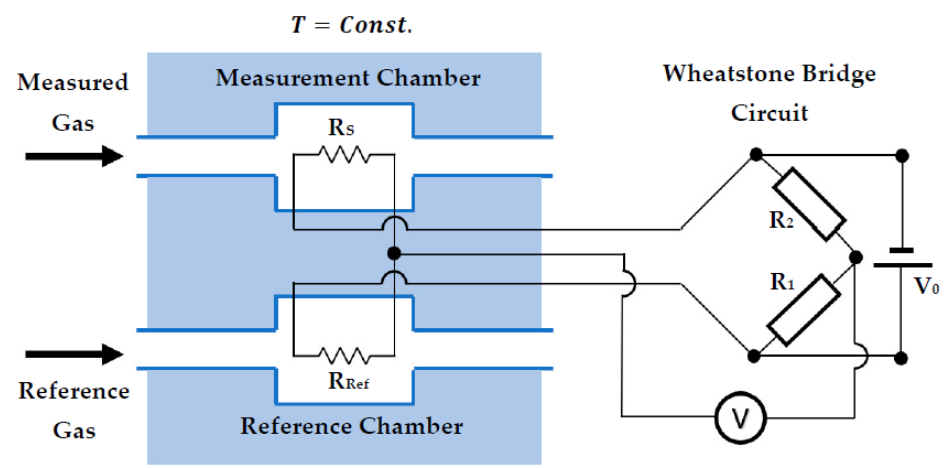
Figure 5. Illustration showing the working principle of a thermal conductivity pellistor with its read-out circuitry included.